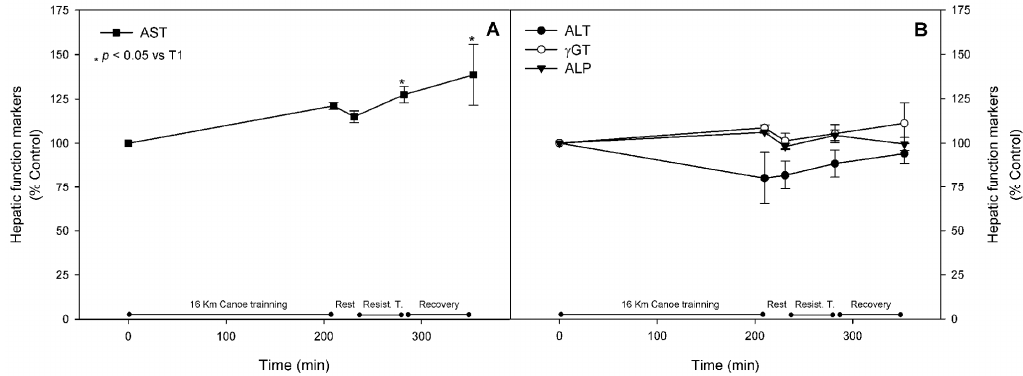
Figure 2. Hepatic injury biomarker. Aspartate aminotransferase (AST), alanine aminotransferase (ALT), γ -glutamyltransferase ( γ GT), and alkaline phosphatase (ALP) were measured as described in materials and methods and are represented as mean ± standard error of percentage values against control. * Indicates statistical difference against control values ( p < 0.05). ( Panel A ) shows AST results and ALT, γ GT, and ALP results are presented in ( Panel B ).